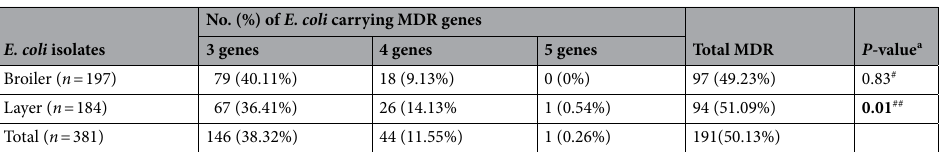
Table 6. Overall prevalence of MDR genes among the investigated E. coli ( n = 381) isolates in relation to type of hens (broiler or layer) in Sylhet division of Bangladesh. a P values calculated using a two-way analysis of variance (ANOVA) without replication. P values < 0.05 are highlighted in bold. # Variance between broiler and layer chickens. ## Variance among the classes of MDR genes.